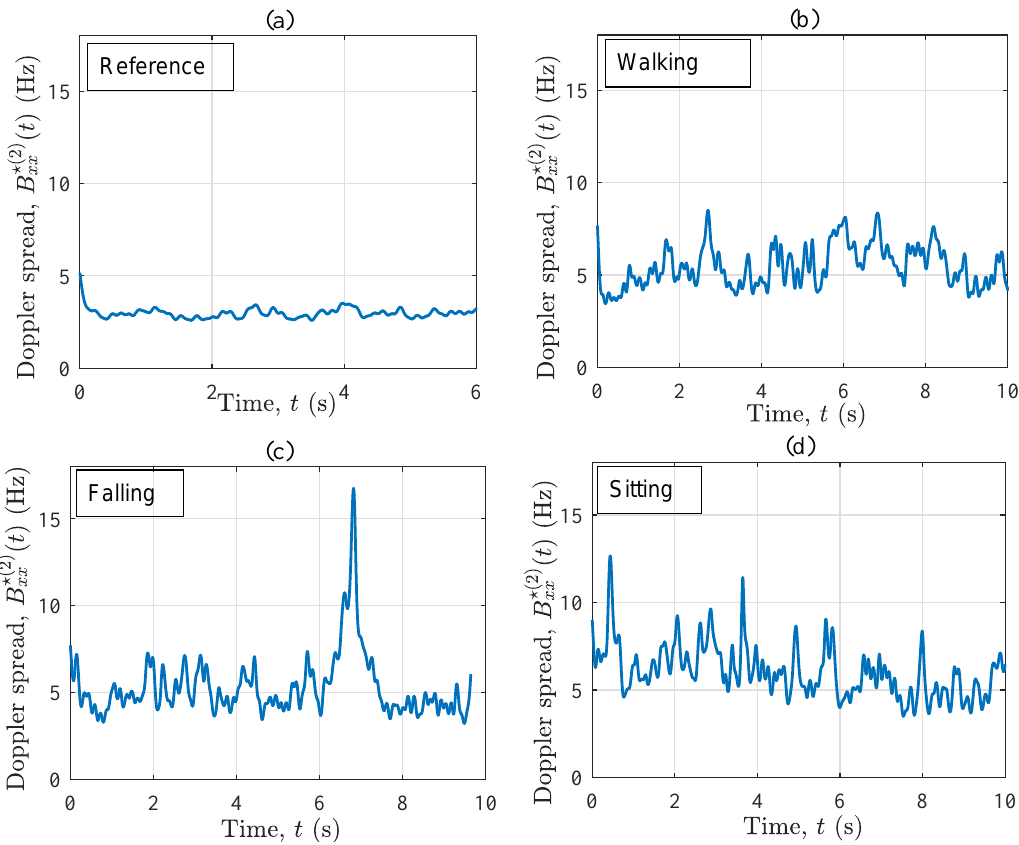
(cid:63) ( 2 ) ( t ) for the four scenarios in S1: ( a ) reference, xx